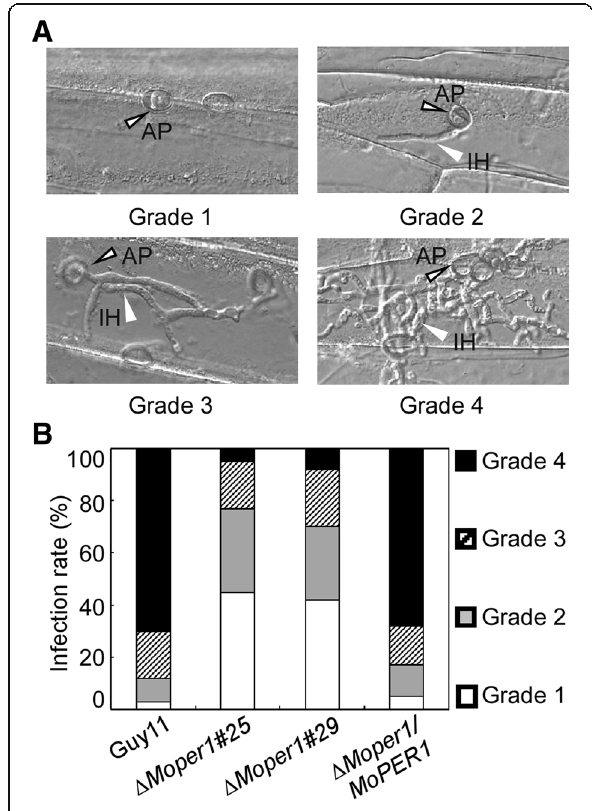
Fig. 8 The infectious hyphae growth on barley leaves. a Excised barley leaves from 7-day-old barley seedings were inoculated with conidial suspension (5 × 10 4 spores/ml). Infectious growth was observed at 24 h post-inoculation (hpi). b Statistical analysis for each type of infectious hyphal shape, for each tested strain; 100 infecting hyphae were counted per replicate and the experiment was repeated three